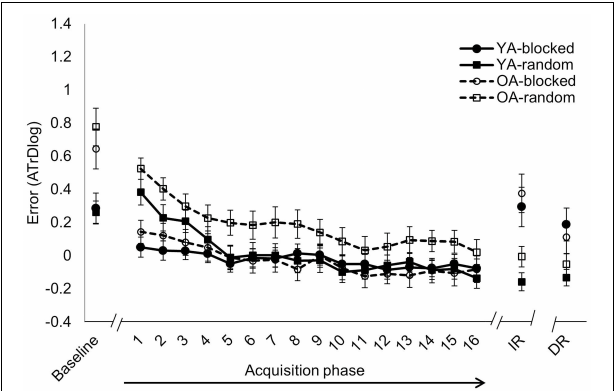
FIGURE 4 | Isofrequency ratio. Error score (ATrD, i.e., the log-transformed average track deviation) for baseline, acquisition phase (TR1-16),